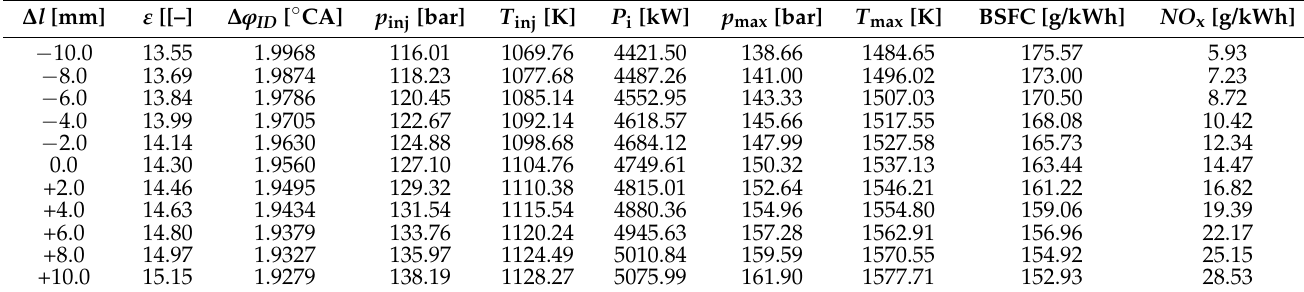
Table 11. Engine parameters and NO x emission changes due to changes in the compression ratio at 50% MCR [22]. ∆ l